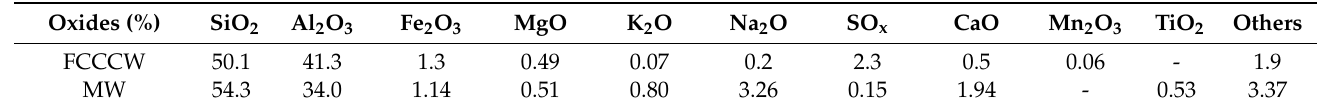
Table 2. Chemical composition of FCCCW and MW (%).